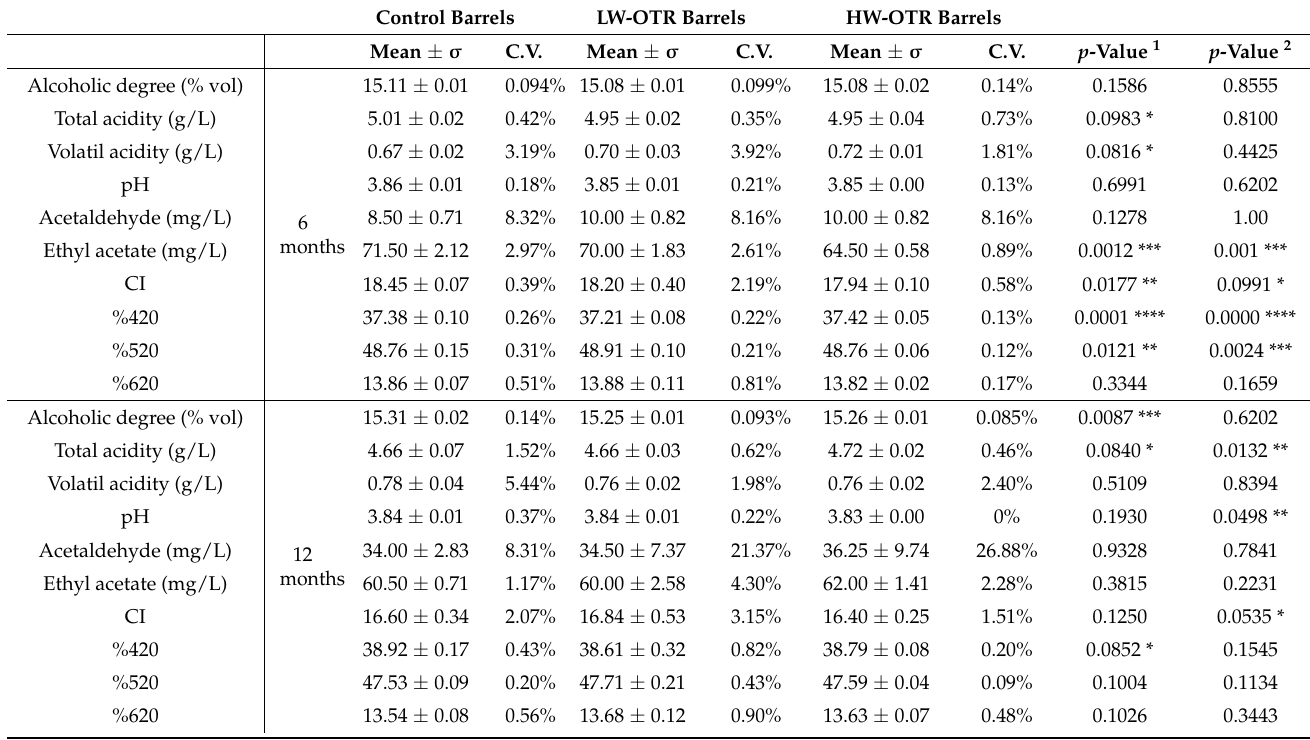
Table 1. Oenological parameters of the same wine aged in different customized oak wood barrels and wine colour parameters. Control